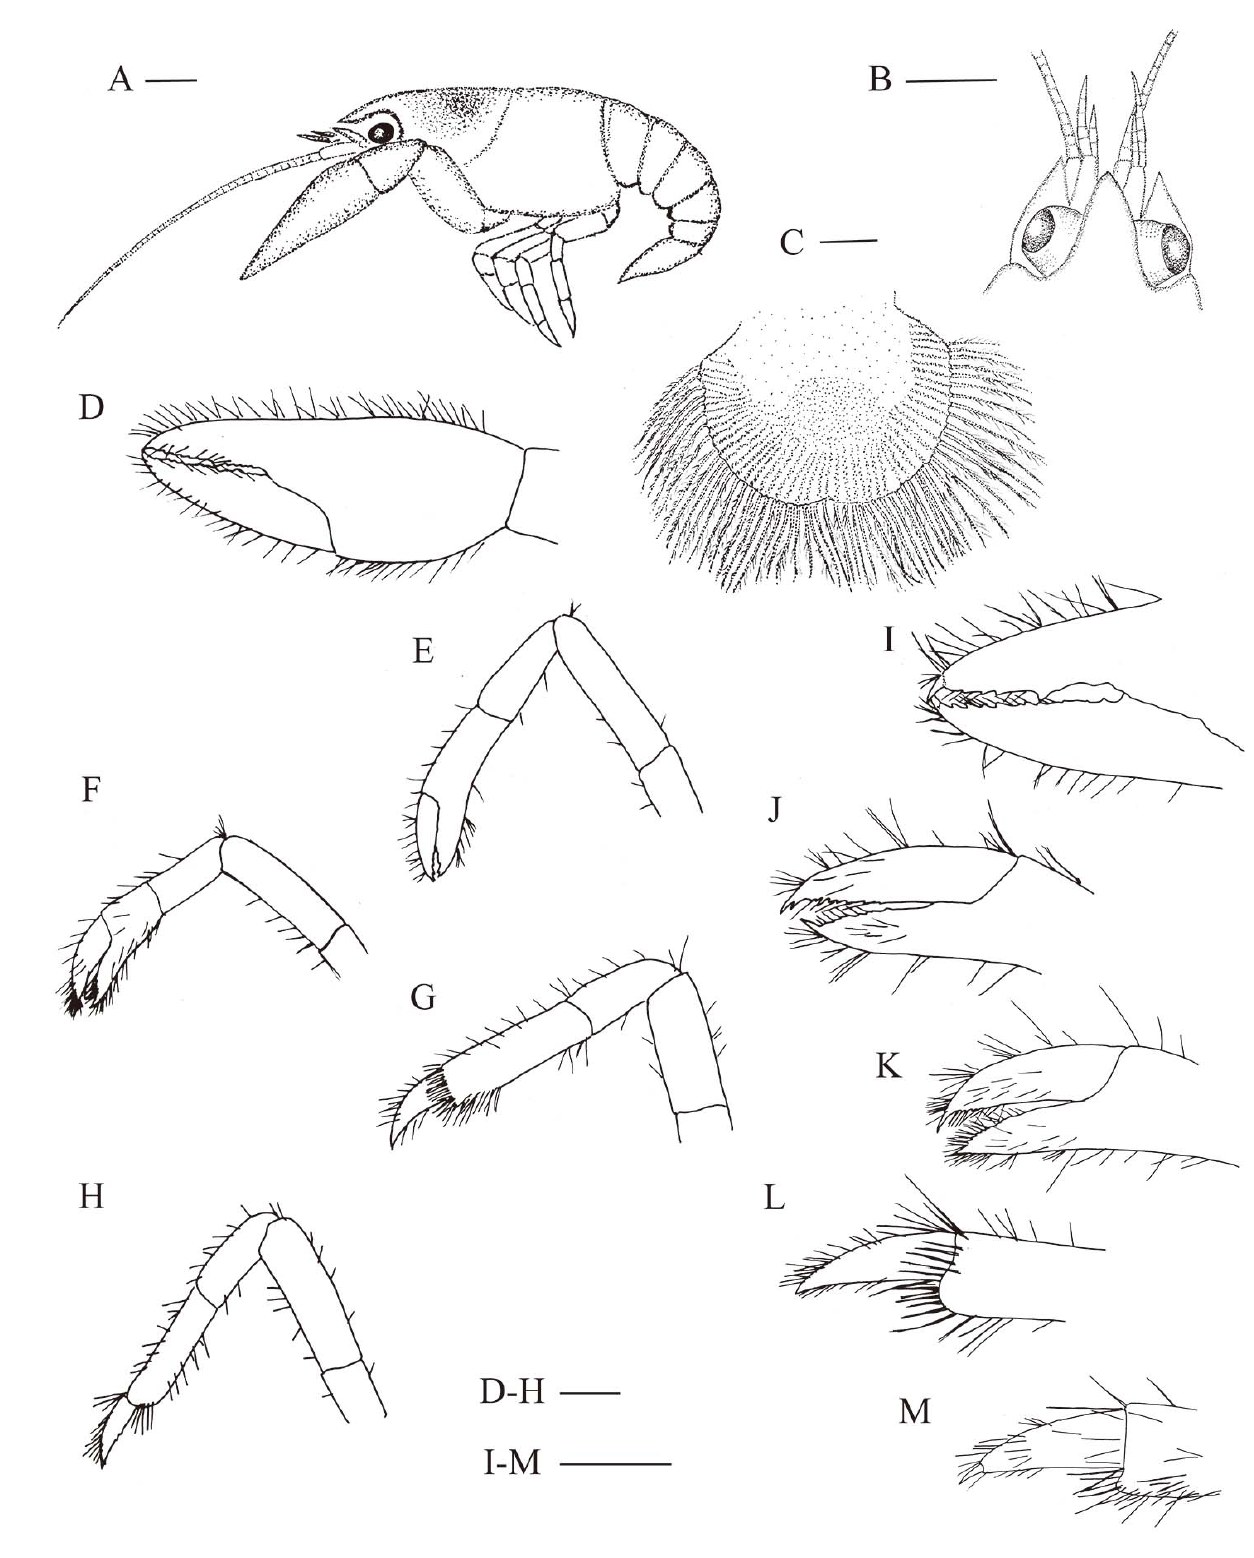
Figure 15. Juvenile Stage II of Cambaroides japonicus. ( A ) Habitus, lateral view; ( B ) eyes and rostrum, dorsal view; ( C ) tail fan, dorsal view; ( D ) posterior edge of tail fan; ( E–I ) pereiopods 1–5, dorsal or lateral view; ( J–N ) distal segments of pereiopods 1–5, dorsal or lateral view. Scale bars: 0.25